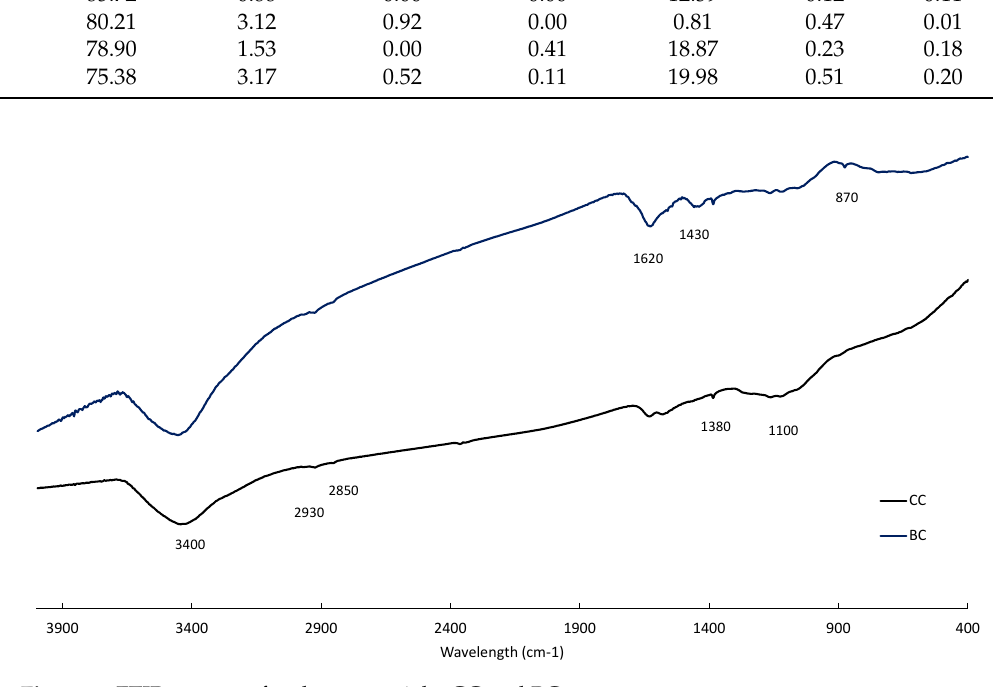
Figure 3. FTIR spectra of carbon materials: CC and BC .